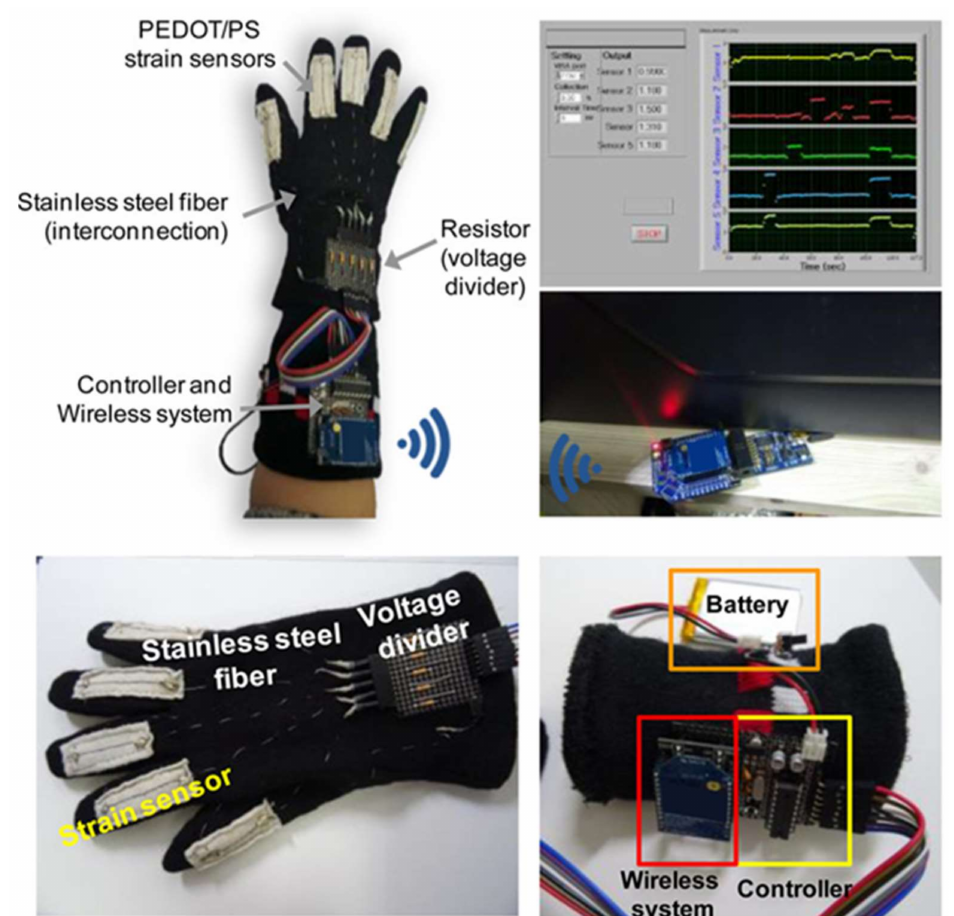
Figure 4. Digital images of a textile-based wearable user-interface device which contains five poly(3,4-ethylenedioxythiophene)/polyester PEDOT/PS strain sensors, stainless steel fiber interconnections, a voltage divider configuration, a battery, and a wireless transmission unit. Reprinted with permission from [63]. Copyright (2017) American Chemical